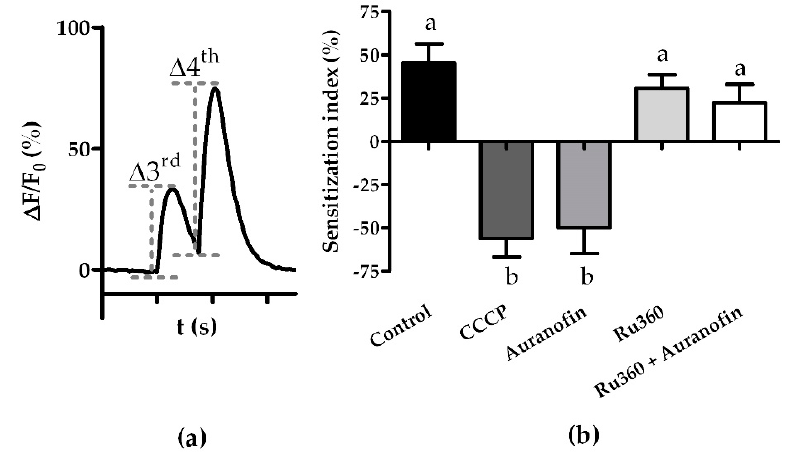
Figure 4. Effect of modulators of mitochondrial Ca 2+ import and export on sensitization index: ( a ) Sensitization efficacy was quantitatively assessed by calculating the “Sensitization Index” [30]. After subtraction of the baseline fluorescence intensity before the delivery of the VUAA1 stimulation, the Sensitization Index was calculated as the difference between the intensity of the fourth and third stimulation ( Δ 4th- Δ 3rd); ( b ) sensitization Indices after treatment with modulators of mitochondrial Ca 2+ import and export calculated as described in ( a ). Data represent mean ± SEM, different letters above the bars indicate significant differences ( p < 0.05) as revealed by Tukey-Kramer post hoc mul- tiple comparison tests.